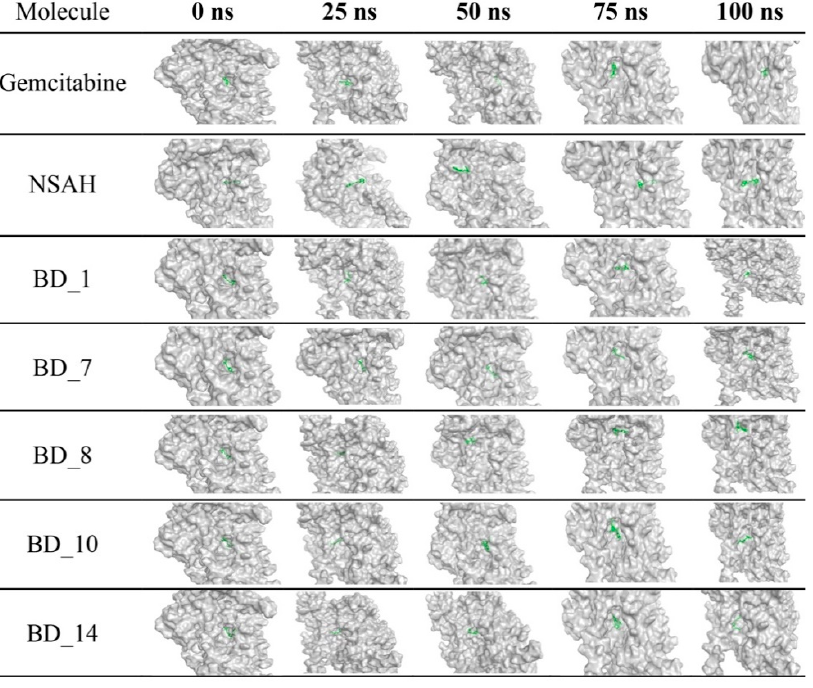
Figure 13. Binding mode in the 3D surface view of hRRM1 inhibitors in 0, 25, 50, 75, and 100 ns of MD simulation.